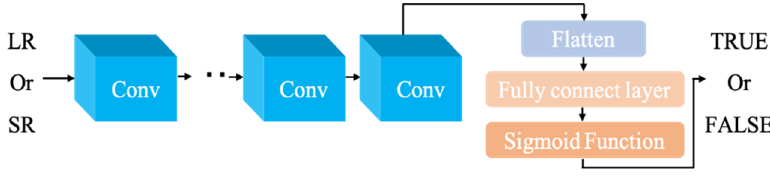
Figure 5. Discriminator structure.